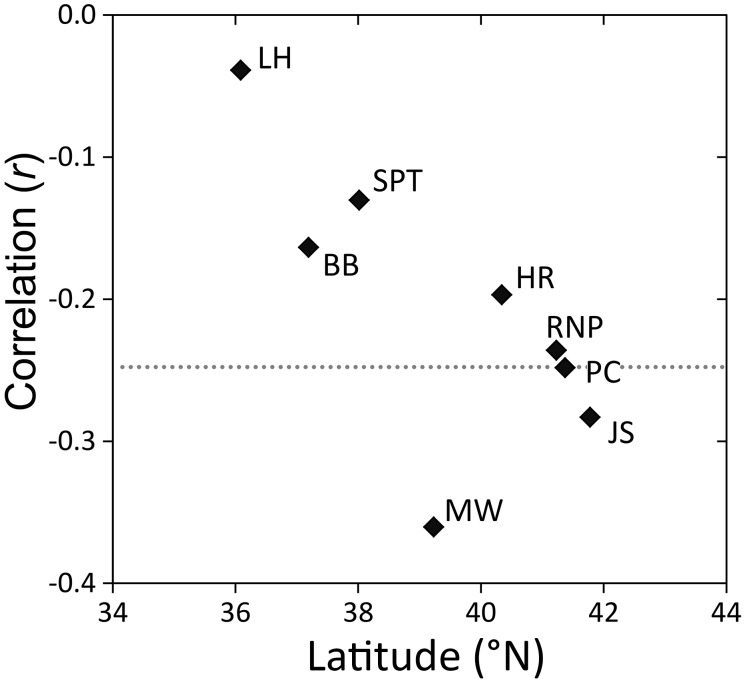
Correlations between residual tree-ring chronologies and reconstructed summer cloudiness for eight Sequoia sempervirens locations.Summer cloudiness (i.e., airport fog with cloud base ≤400 m elevation) reconstructed by Johnstone and Dawson [42] for June–September over a 108-year common period (1901–2008). Dotted line represents cutoff for statistical significance (P<0.01).